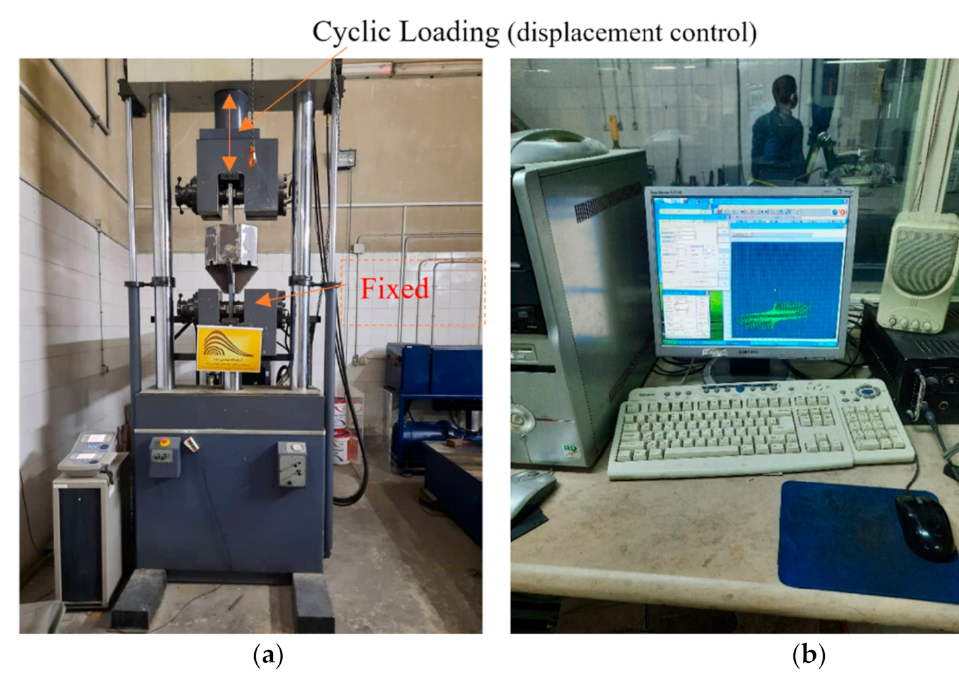
Figure 4. ( a ) Test setup; ( b ) automatic capturing of the hysteresis curve.